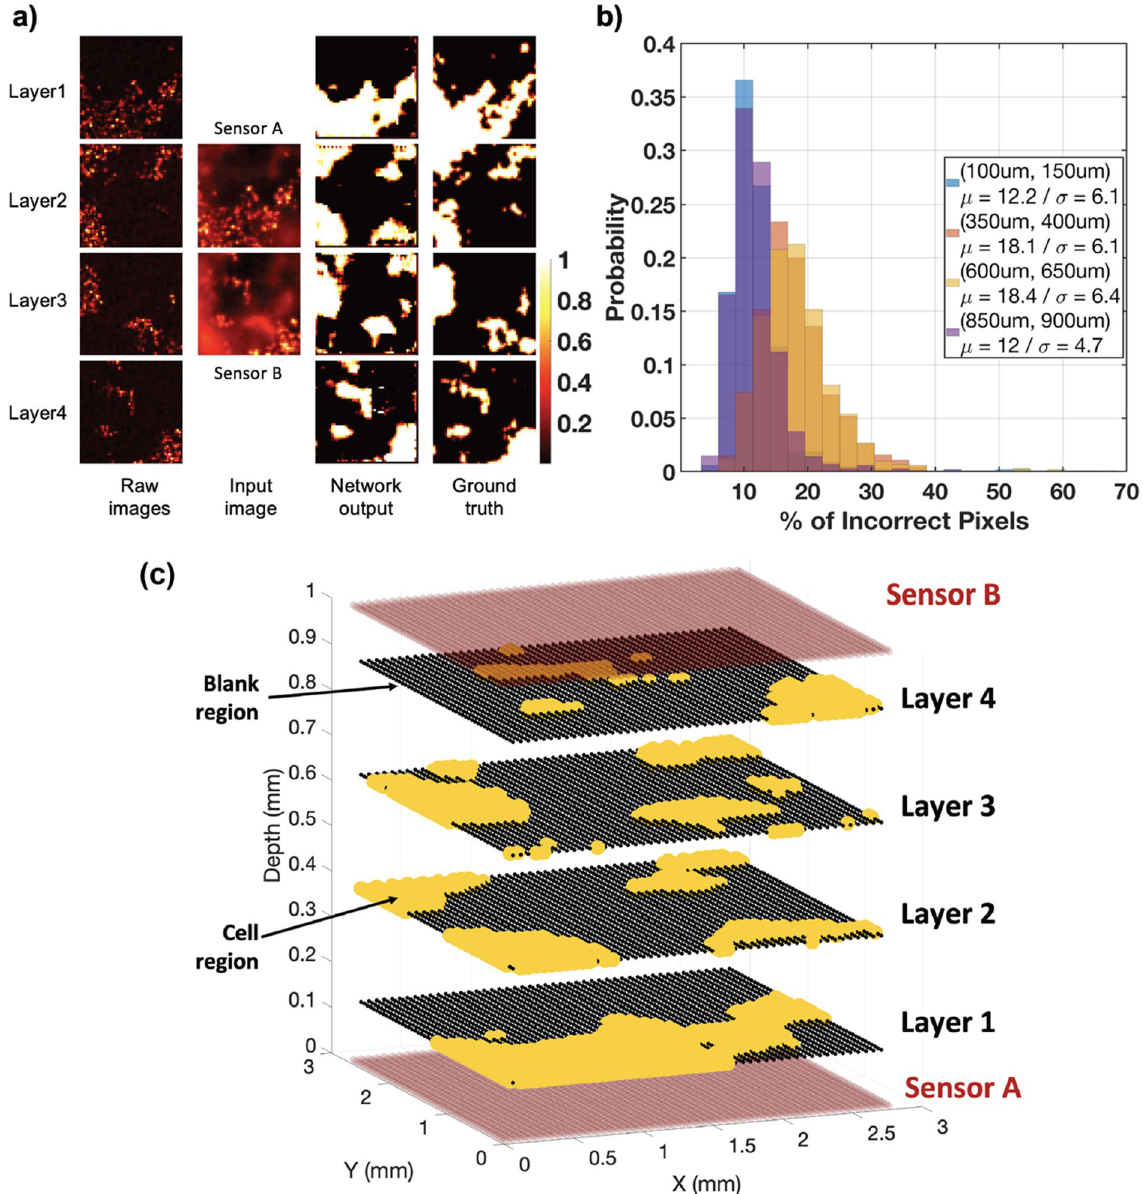
Figure 4. Evaluation of the CNN with two sensors: ( a ) Overlaid input images from 4 raw images corresponding to each layer before applying the PSF, network output images and ground truth depth maps. ( b ) Distribution of average pixel error for each layer with averaged error rates of 12.2%, 18.1%, 18.4% and 12% for layers 1 to 4, respectively. (c) Spatial (3D) reconstruction (using network outputs) of the sample test input, where black, yellow and red respectively represent blank (empty of cells) spaces, regions containing cells, and sensor